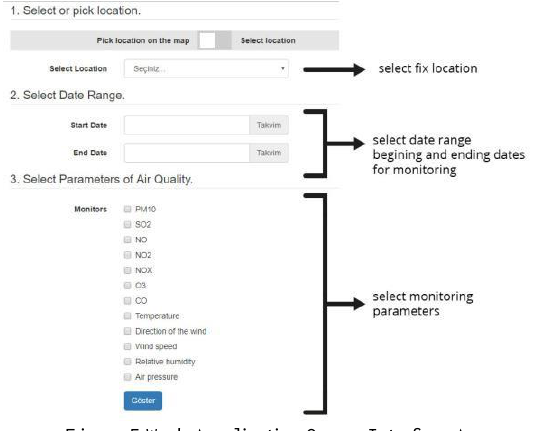
Figure 5.Web Application Query Interface-A